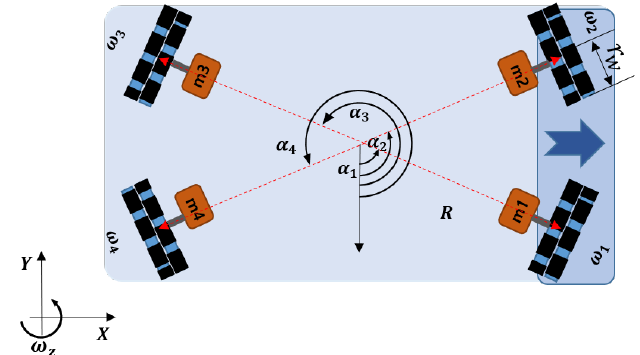
Figure 2. The schematic diagram and coordinate system of the parking